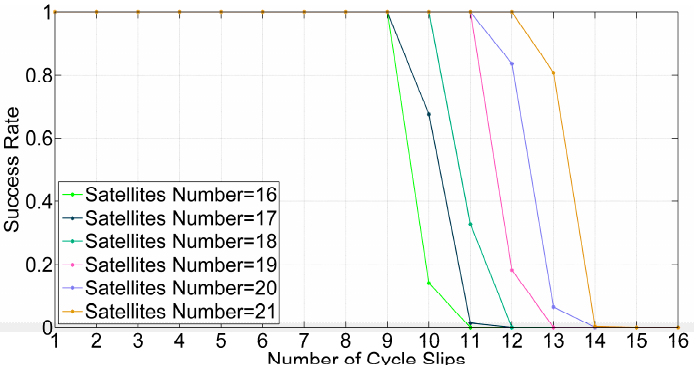
Figure 7. Success rates of detecting cycle slips by different numbers of satellites and cycle slips with GPS + BDS.